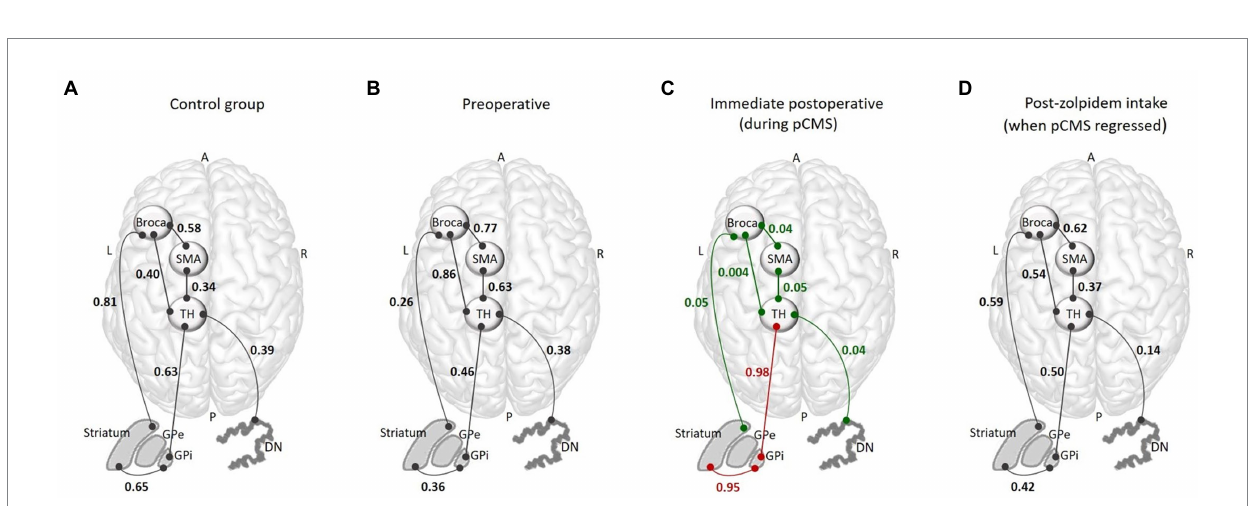
FIGURE 2 Graphical summary of the FC results within the dentato-thalamo-cortical and cortico-striato-pallido-thalamo-cortical loops for the control group for each time-point. The functional connectivity analysis included the following ROIs: Broca’s area and the left supplementary motor area (SMA), left thalamus, right dentate nucleus (DN), internal globus pallidus (GPi), and left striatum. Altogether, these regions constitute the dentato-thalamo-cortical and cortico-striato-pallido-thalamo-cortical loops. (A) Mean of the correlation coefficients obtained for the control group for each pair of ROIs. (B) FC correlation coefficients for each pair of ROIs obtained in the preoperative images. (C) FC correlation coefficients for each pair of ROIs obtained in the immediate postoperative images, showing decreased (in green) and increased (in red) FC. (D) FC correlation coefficients for each pair of ROIs obtained in the post-zolpidem intake, showing a return to the normal pattern. R, right; L, left; A, anterior; P, posterior; pCMS, postoperative cerebellar mutism syndrome; FC, functional connectivity; SMA, supplementary motor area; TH, thalamus; DN, dentate nucleus; GPe, external globus pallidus; GPi, internal globus pallidus; ROIs, regions of